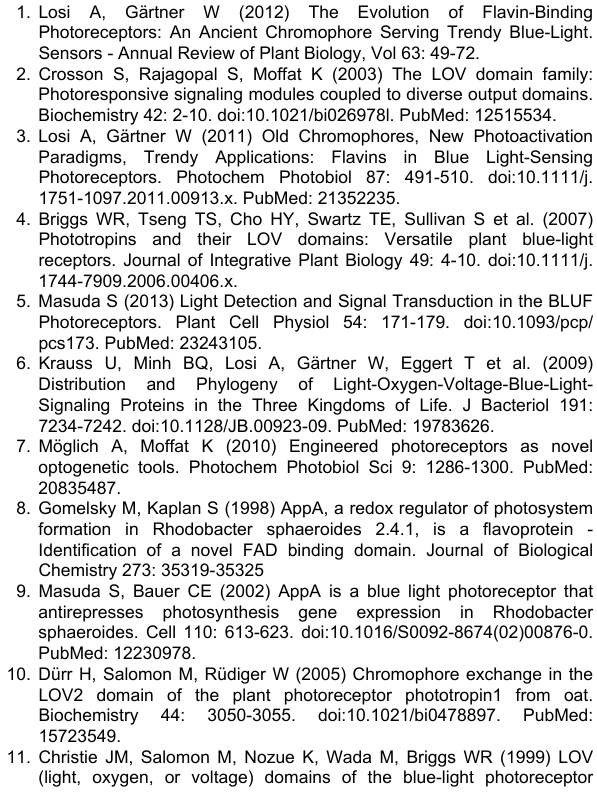
Figure S8. Superimposed 1 H- 15 N-TROSY spectra of YtvA reconstituted with FMN and RF. The 1 H- 15 N-TROSY spectrum of YtvA reconstituted with FMN and RF is colored in magenta and green, respectively. Both samples were uniformly 2 H- 15 N-labeled. Resonances belonging to amino acids significantly or slightly affected by exchange of FMN against RF are labeled with residue type and sequence position (SC: Unassigned amide resonances most-likely belonging to side- chains). See main text for details. Spectra were acquired at 27°C on a 600 MHz NMR spectrometer (Bruker Avance III) equipped with a 5 mm triple resonance PFG (z-axis) cryo probe head.